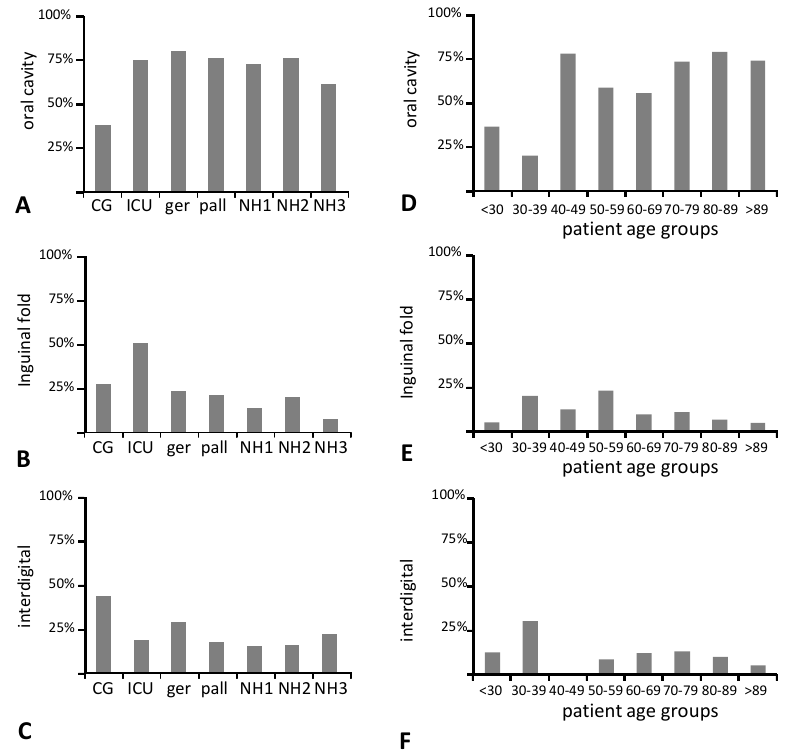
Figure 1. Mean rates of fungal colonization. ( A – C ) stratified by subcohort; ( D – F ) stratified by patient age group. ( A , D ) oral cavity; ( B , E ) inguinal fold; ( C , F ) interdigital; CG, control group; ICU, intensive care unit; ger, geriatric care unit; pall, palliative care unit; NH1-3, nursing homes 1-3. Table 2. Culture composition from the oral specimen.